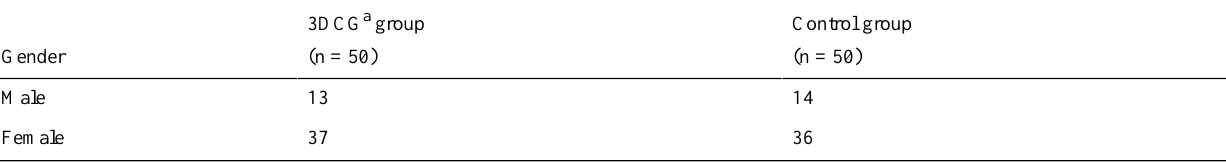
Table 1. Gender distribution in the two study groups (n =